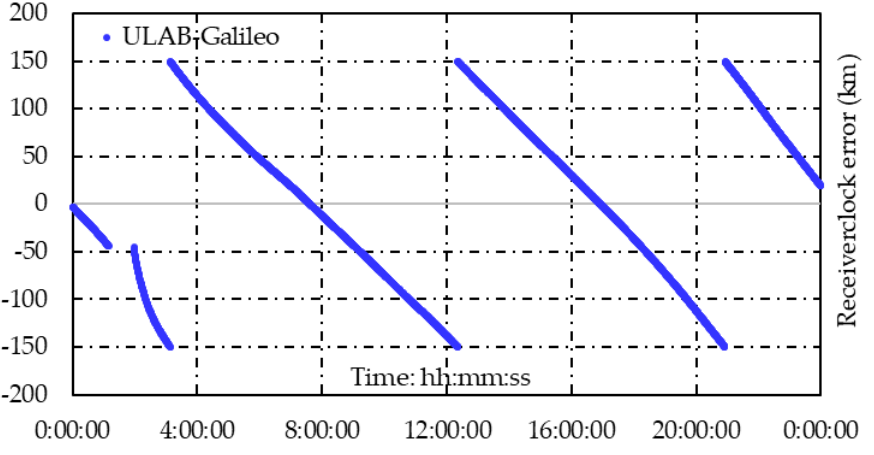
Figure 5. Receiver clock error from PPP with Galileo.